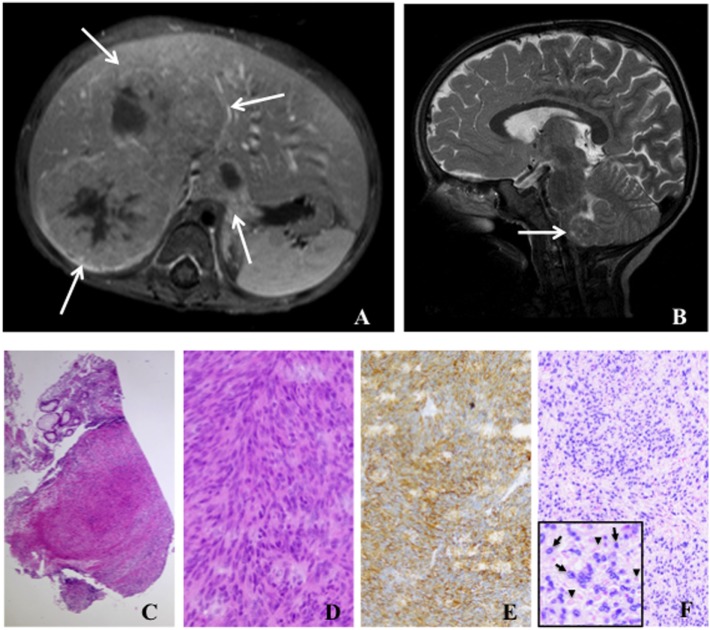
Radiology and histology of Epstein–Barr virus positive (EBV+) smooth muscle tumors. (A) Abdominal magnetic resonance image (T1 fat-sat post contrast medium) shows solid liver tumors involving segments I and V–VIII (arrows). (B) Cranial magnetic resonance image (T2 sagittal) displays a tumor in the medulla oblongata (arrow). (C) Low-power (50×) examination of a colon biopsy shows a prominent nodular cellular proliferation in the mucosa and submucosa (D) High-power (400×) magnification displays fascicles of fusiform spindle cells with abundant eosinophilic cytoplasm and elongated or ovoid nuclei without significant atypia or mitoses suggesting a mesenchymal neoplasia of smooth muscle origin (E). Immunohistochemistry for smooth muscle actin (200×) confirms the smooth muscle nature of the tumor (F). EBV association is demonstrated by in situ hybridization for EBV-encoded RNA (EBER) in the same lesion (200×). Inlet displays positive cells with EBER in darkly stained basophilic nuclei (arrows) and negative cells with faint eosinophilic nuclei (arrowheads).